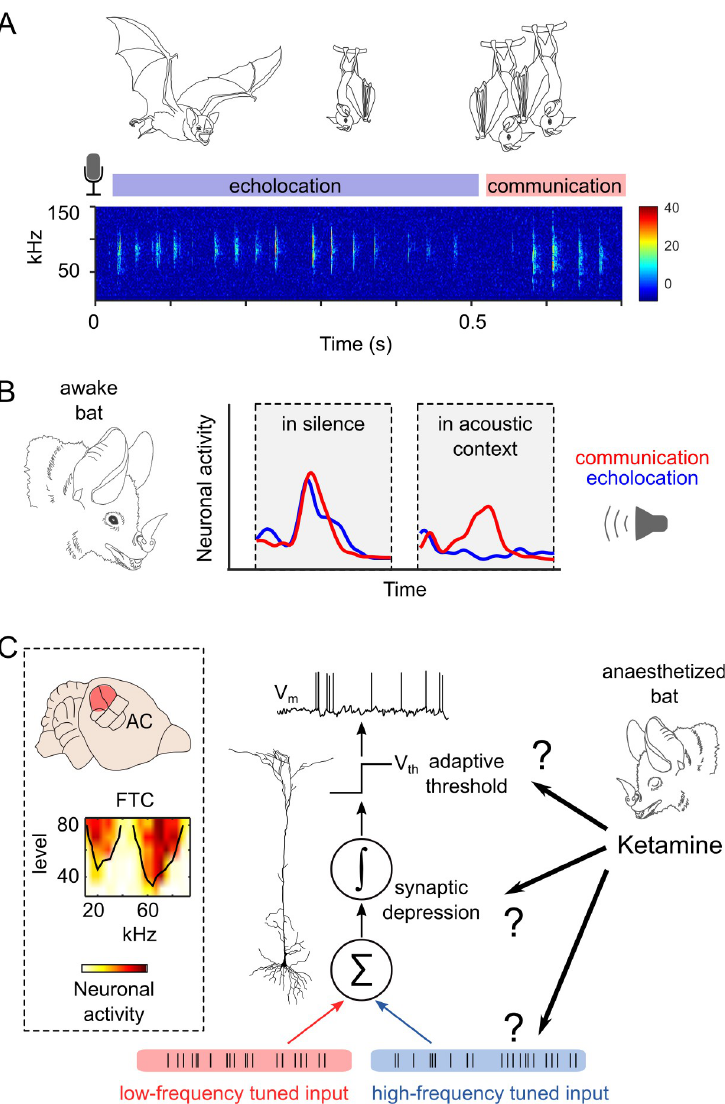
Fig 1. Effects of anaesthesia on context-dependent processing of vocalisations in the cortex of bats. ( A ) A representative spectrogram of natural bat vocalisations obtained from a group of bats. The audio recording is composed of a mixture of echolocation pulses and social calls uttered by several conspecifics roosting together. The colour bar indicates sound amplitude (arbitrary units). ( B ) Response of one cortical neuron to playbacks of echolocation and communication calls heard in silence (left) and after acoustic contexts (right). The responses were recorded in the awake state. Data from [23]. ( C ) Top left: Location of the bat auditory cortex (AC). The HF cortical fields that contain multifunctional neurons (such as that represented in B) are highlighted in red. Below: A characteristic multipeaked frequency tuning curve (FTC) from these neurons is shown. Right: An integrate-and-fire neuron model reproduces the context-dependent processing observed experimentally in awake bats. In theory, the known effects of ketamine on evoked responses can be used to predict ketamine effects on context-dependent processing in the bat cortex. Data supporting panel B can be found in “all_psth.mat” and the underlying code in “Fig 1B.m,” both in “Ephys data” folder in